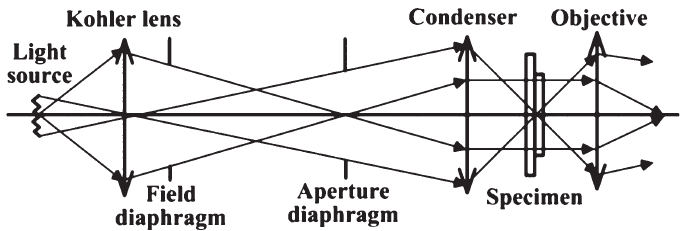
Fig. 2. The schematic relation between the Abbe condenser and the objective in the Kohler